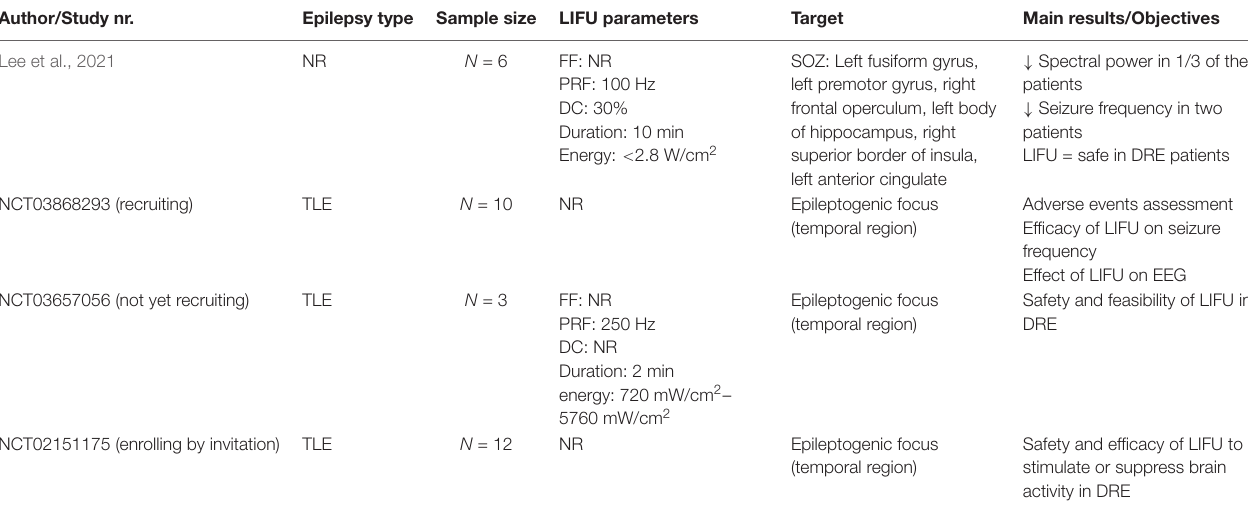
TABLE 4 | Overview of published and ongoing clinical trials testing the effect of LIFU in epilepsy patients. Author/Study